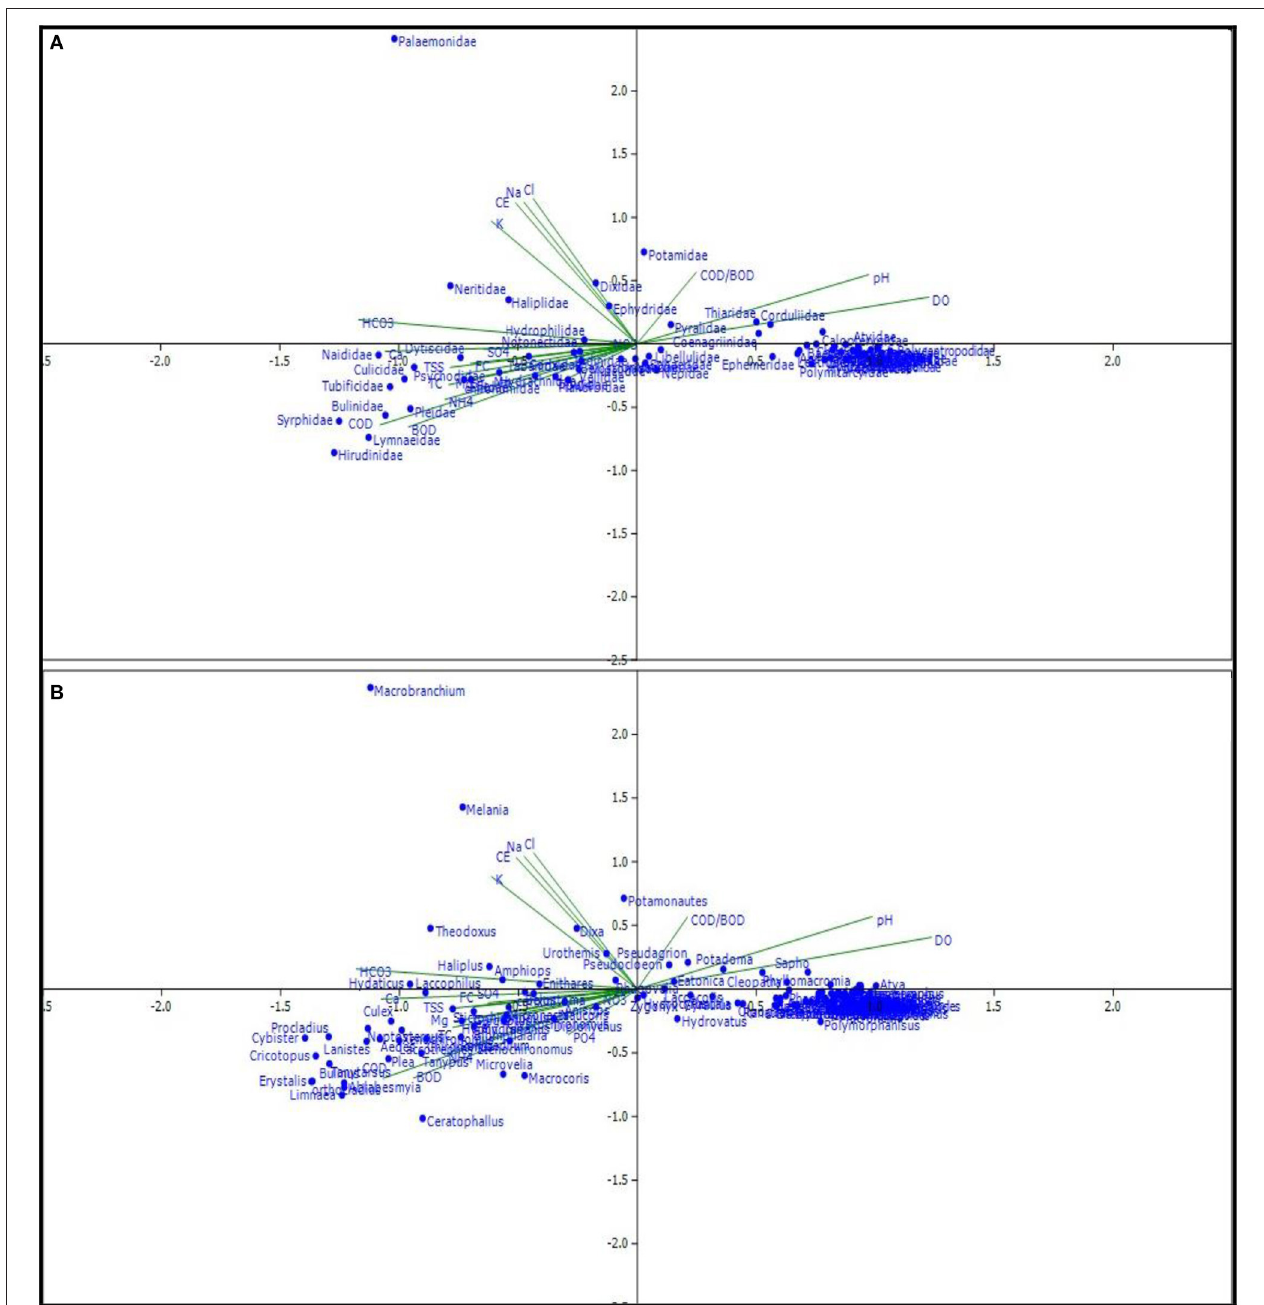
FIGURE 3 | A canonical correspondence analysis (CCA) biplot showing the association between water quality parameters and abundance of macroinvertebrate family resolution (A) and genera resolution (B) .